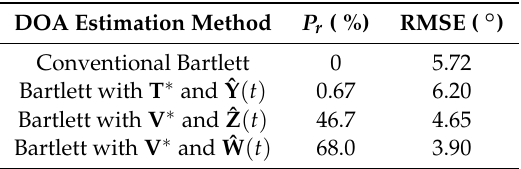
Table 2. Resolution probabilities and root mean squared errors for two target vehicles located at [ − 1.7 ◦ , 4.6 ◦ ]